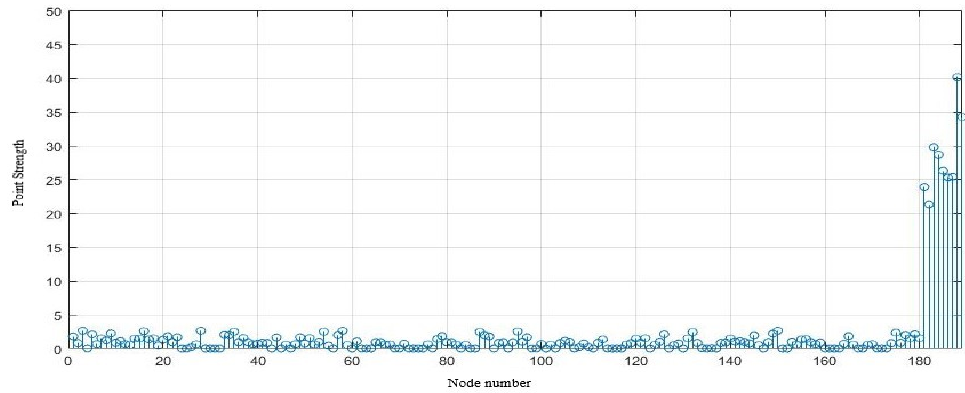
Figure 9. Node node intensity.